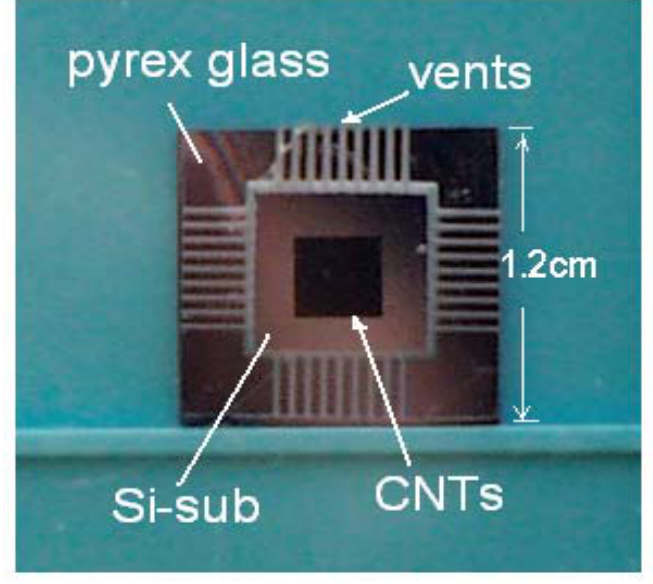
Figure 1. Image of pyrex glass and Si substrate after anodic